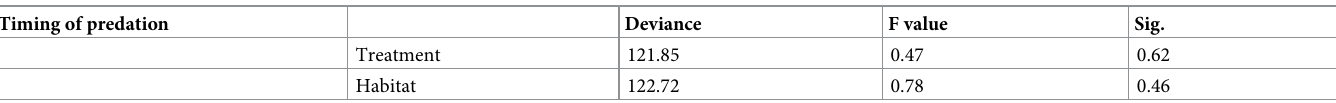
Table 7. Timing of predation in relation to habitat and treatment (General Linear Model using daytime/nighttime as response variable, N = 91 nests). Timing of